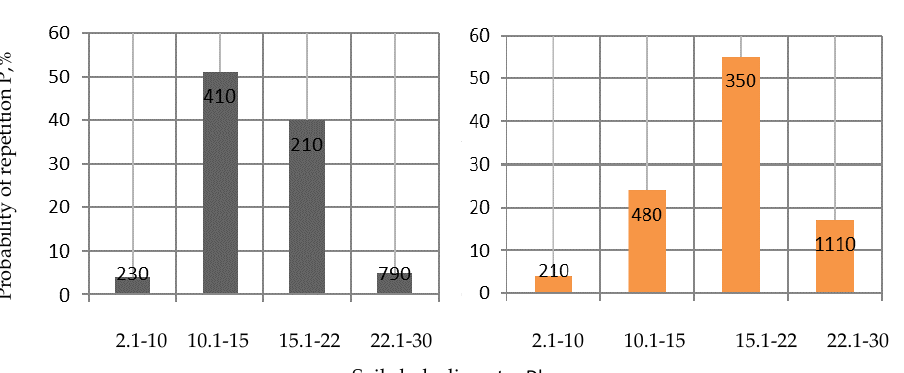
Table 1. The results of studies on the dynamic destruction of soil clods.